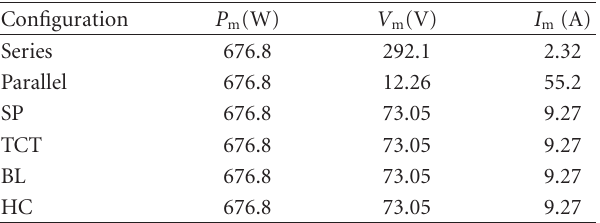
Table 2: Comparisons of Configurations under Uniform Irradiance